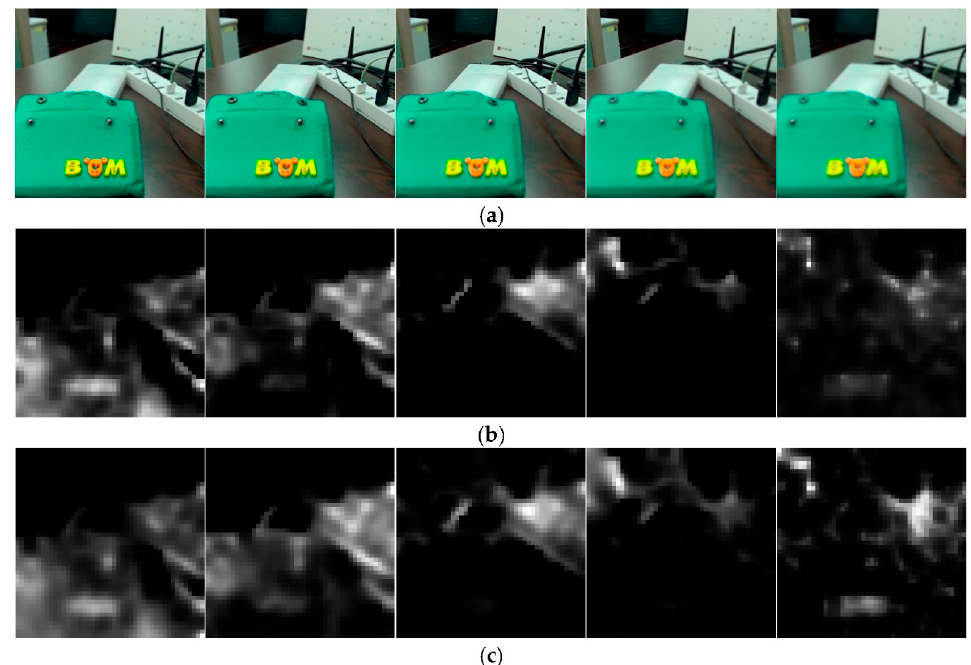
Figure 7. In-focused regions of the different focal stack images using sum of modified Laplacian (SML) and SUML: ‘Bag’ dataset; ( a ) The input images of different focal lengths; ( b ) SML of stack images; and ( c ) SUML of stack images.